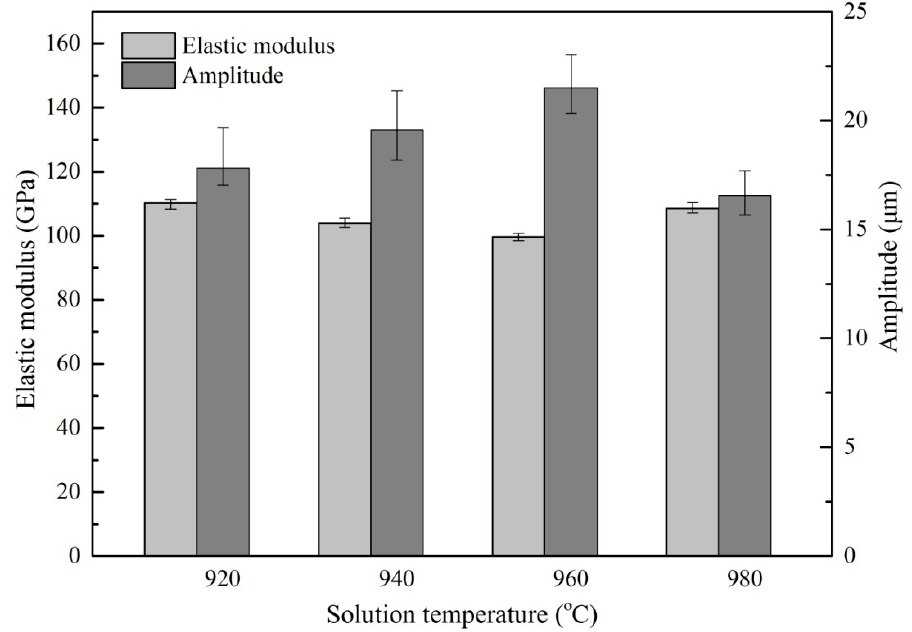
Figure 9. The ultrasonic amplitude and the elastic modulus of Ti6Al4V alloy specimens under different solid solution temperature.